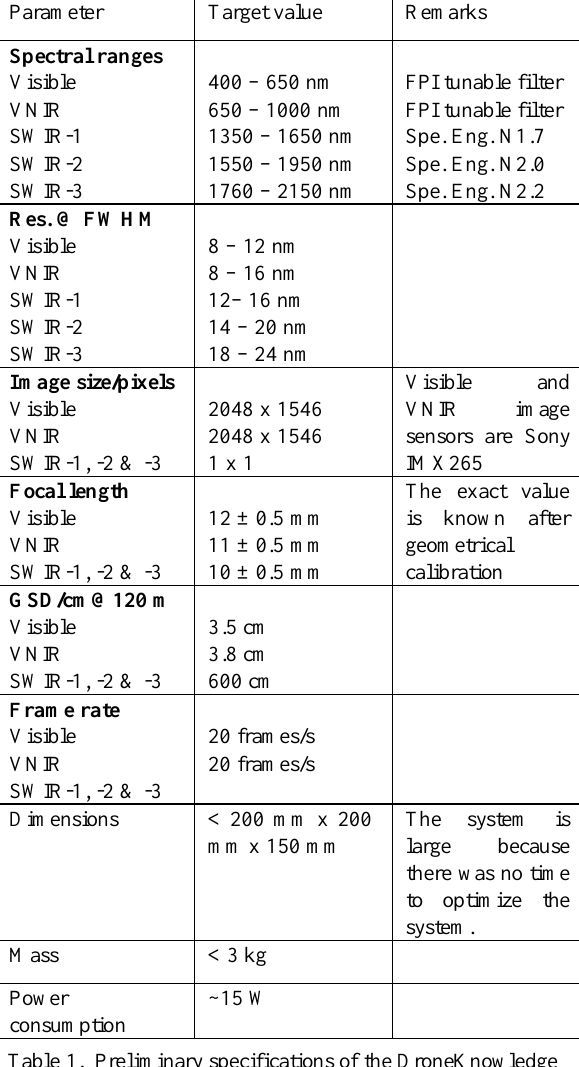
Table 1. Preliminary specifications of the DroneKnowledge Summer 2017 hyperspectral imaging system.